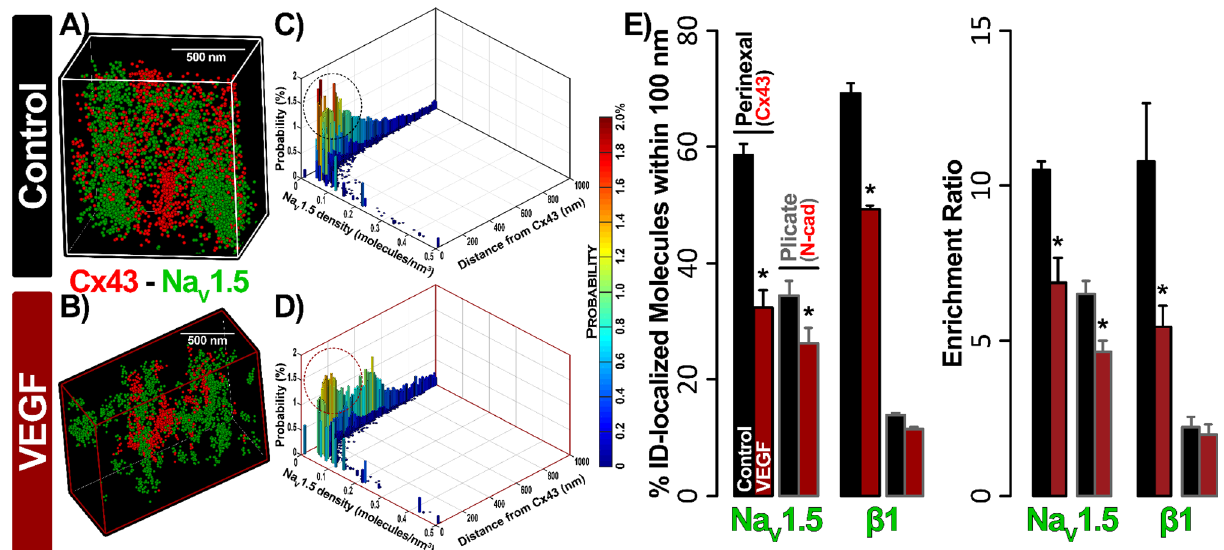
Figure 9. STORM-RLA analysis of Na V 1.5, β1 localization. Representative 3D STORM images of a Cx43 cluster and associated Na V 1.5 clusters from ( A ) control and ( B ) VEGF-treated murine atria. ( C, D ) Bivariate histograms of Na V 1.5 cluster density as a function of distance from Cx43 clusters. Dashed circles highlight the decrease in Na V 1.5 clusters located near Cx43. ( E ) Summary plots of STORM-RLA results. Left: % of ID-localized Na V 1.5 and β1 located within 100 nm of Cx43 (GJ) and N-cad (MJ) clusters. Right: Enrichment ratio, calculated as the ratio of Na V 1.5/β1 cluster density within 100 nm of Cx43 (GJ) and N-cad (MJ) clusters to Na V 1.5/β1 cluster density at other ID sites (n = 3 hearts/group, 10 images/heart; * p < 0.05 vs. control).